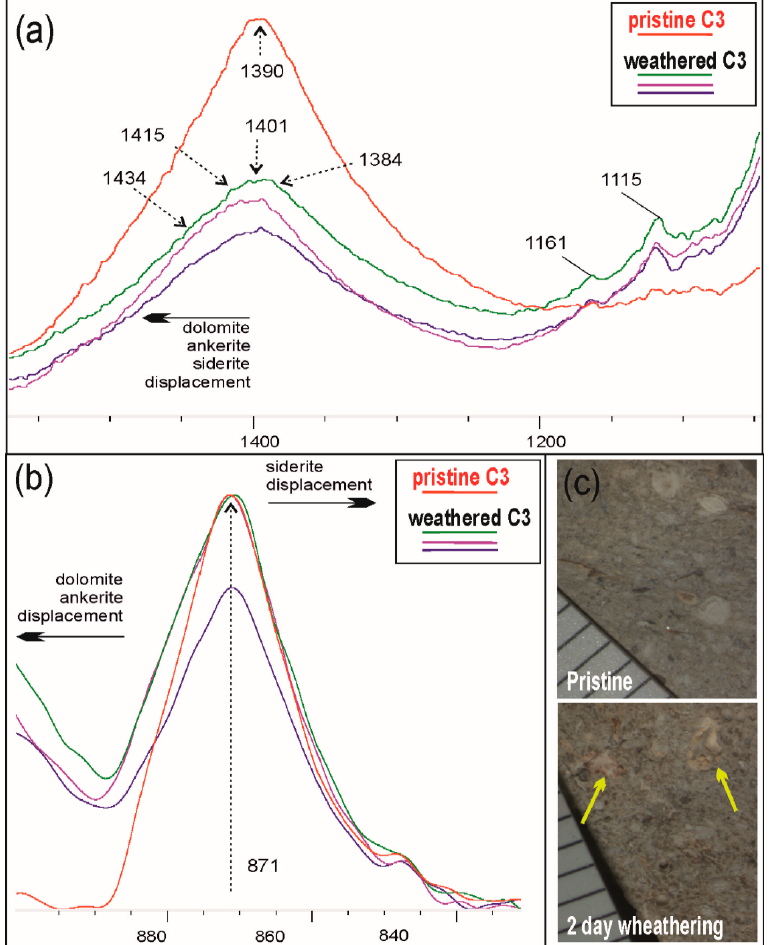
Figure 12. FT-IR spectra zoomed in ( a ) in the 1500–1040 cm − 1 and ( b ) in the 920–800 cm − 1 range of C3 samples ( c ) with textural changes between pristine (in red) and different weathered portions (blue, green and magenta lines) after 2 days of experiments. Bands displacement from